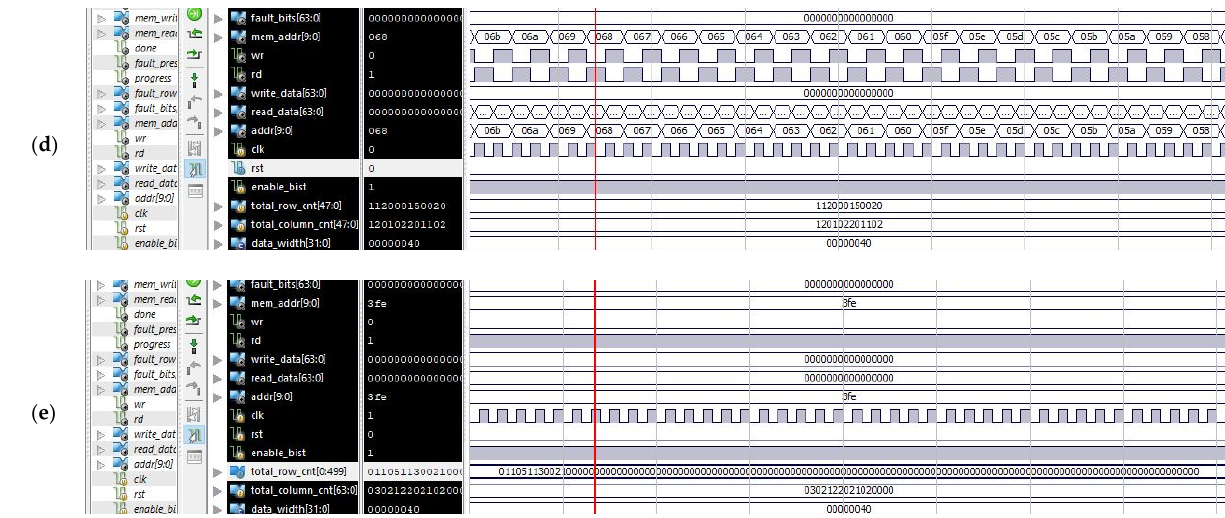
Figure 6. Simulation results for the proposed BISR block: ( a ) writing memory with all 0s; ( b ) BISR operations for performing read–write operations into and from memory; ( c ) BISR operations fault and type detections and store fault information; and ( d ) BISR flow and fault count detection row–column wise and memory repair for 8 k memory. ( e ) BISR flow and fault count detection row–column wise and memory repair for 16 K memory.